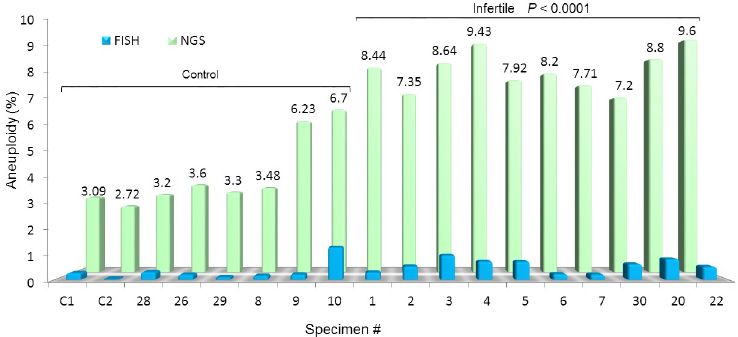
Fig 4. Aneuploidy assessment by FISH and NGS in the study population. FISH analysis, depicted by the blue histogram, failed to evidence any difference among the groups. NGS, however, reported a remarkable and significant aneuploidy rate in the infertile group when compared to the fertile control ( P < 0.0001).